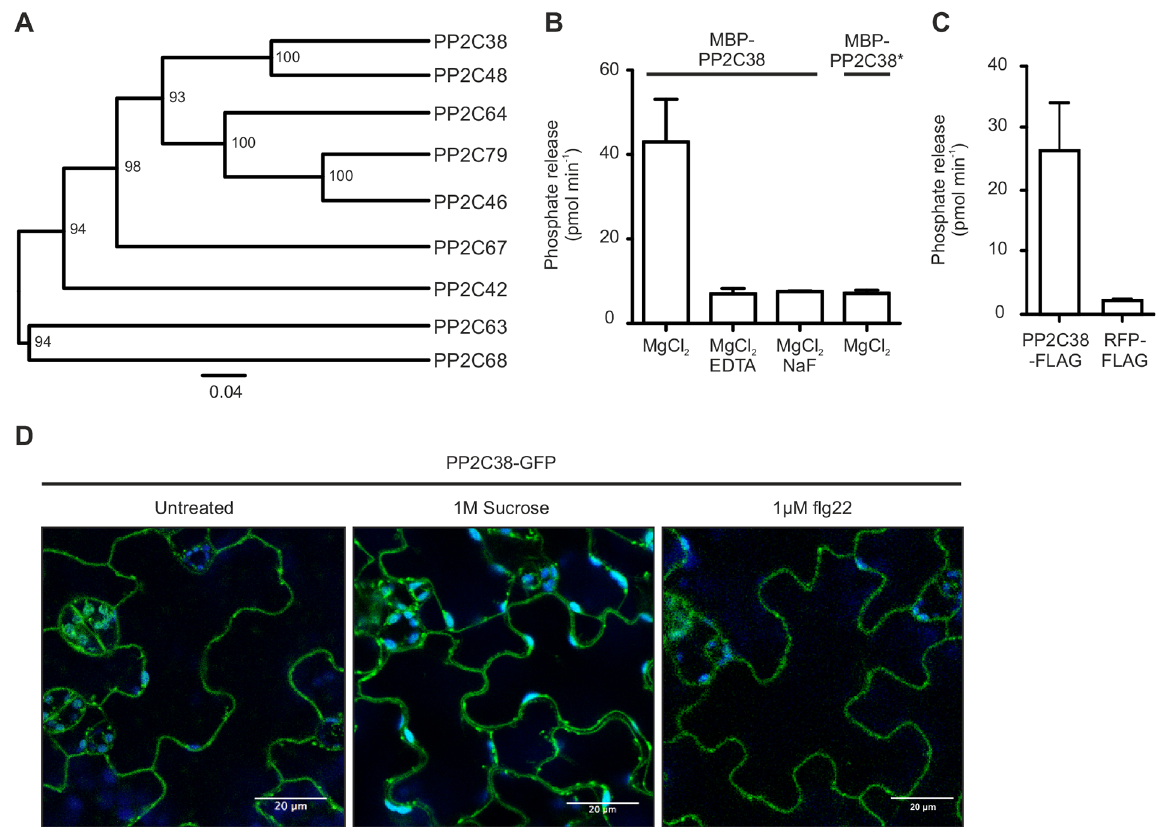
Fig 2. PP2C38 is an active plasma membrane-localized phosphatase. (A) Phylogenetic analysis of Arabidopsis PP2C clade D. Protein sequences were aligned using clustalW and the tree generated using UPGMA. Numbers indicate bootstrap values from 100 replicates. (B) PP2C38 is an active phosphatase in vitro . Recombinant MBP-PP2C38 or MBP-PP2C38 * proteins (where PP2C38 * is a catalytically-inactive variant) were incubated with a synthetic phosphopeptide in the presence or absence of Mg 2+ ions, cation chelator EDTA or phosphatase inhibitor NaF. Release of inorganic phosphate was quantified using a colorimetric assay. Values are averages ± SD (n = 3). (C) PP2C38 is an active phosphatase in vivo . Immunoprecipitated PP2C38-FLAG or control RFP-FLAG proteins from N . benthamiana leaves were incubated with a synthetic phosphopeptide, and release of inorganic phosphate was quantified using a colorimetric assay. (D) PP2C38 localizes to the plasma membrane. Confocal microscopy of Arabidopsis cotyledons stably expressing PP2C38-GFP . Plasmolysis (arrows) with 1M sucrose indicates plasma membrane localization. Treatment with 1 μ M flg22 for 30 min did not alter PP2C38 localization.